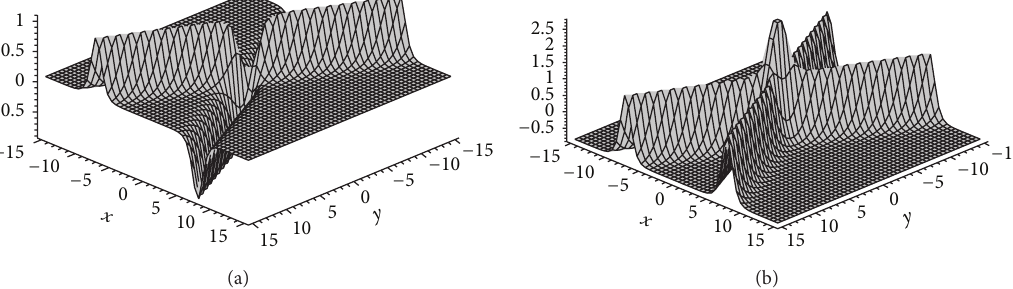
Figure 1: A computer simulation about two-soliton solution collision at 𝑡 = 0 in Family 1, with parameters 𝐹 1 (𝑡) = 𝑡 , 𝐹 2 (𝑦) = −0.5𝑦 , = 𝐶 = 𝐶 = 1 , 𝐶 = 𝐶 = 0 , 𝜙 = tanh, and 𝜓 = tanh. 𝐶 1 3 5 2 4